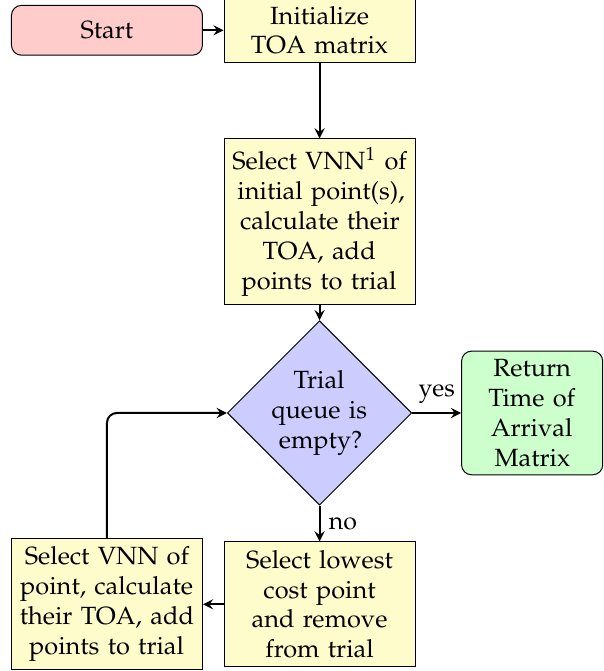
Figure 7. FMM: Procedure to find Time of Arrival (TOA) matrix. 1: Von Neumann’s